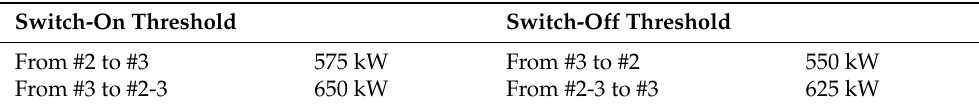
Table 2. Chiller sequencing strategy: switch-on and switch-off